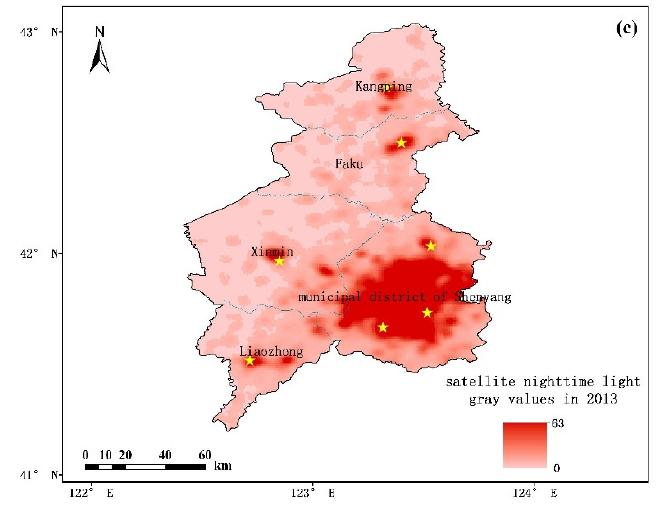
Figure 3. Spatial distributions of satellite nighttime light gray values in Shenyang in ( a ) 1993, ( b ) 2003, and ( c ) 2013 (yellow dots represent urban stations and blue dots represent rural stations).